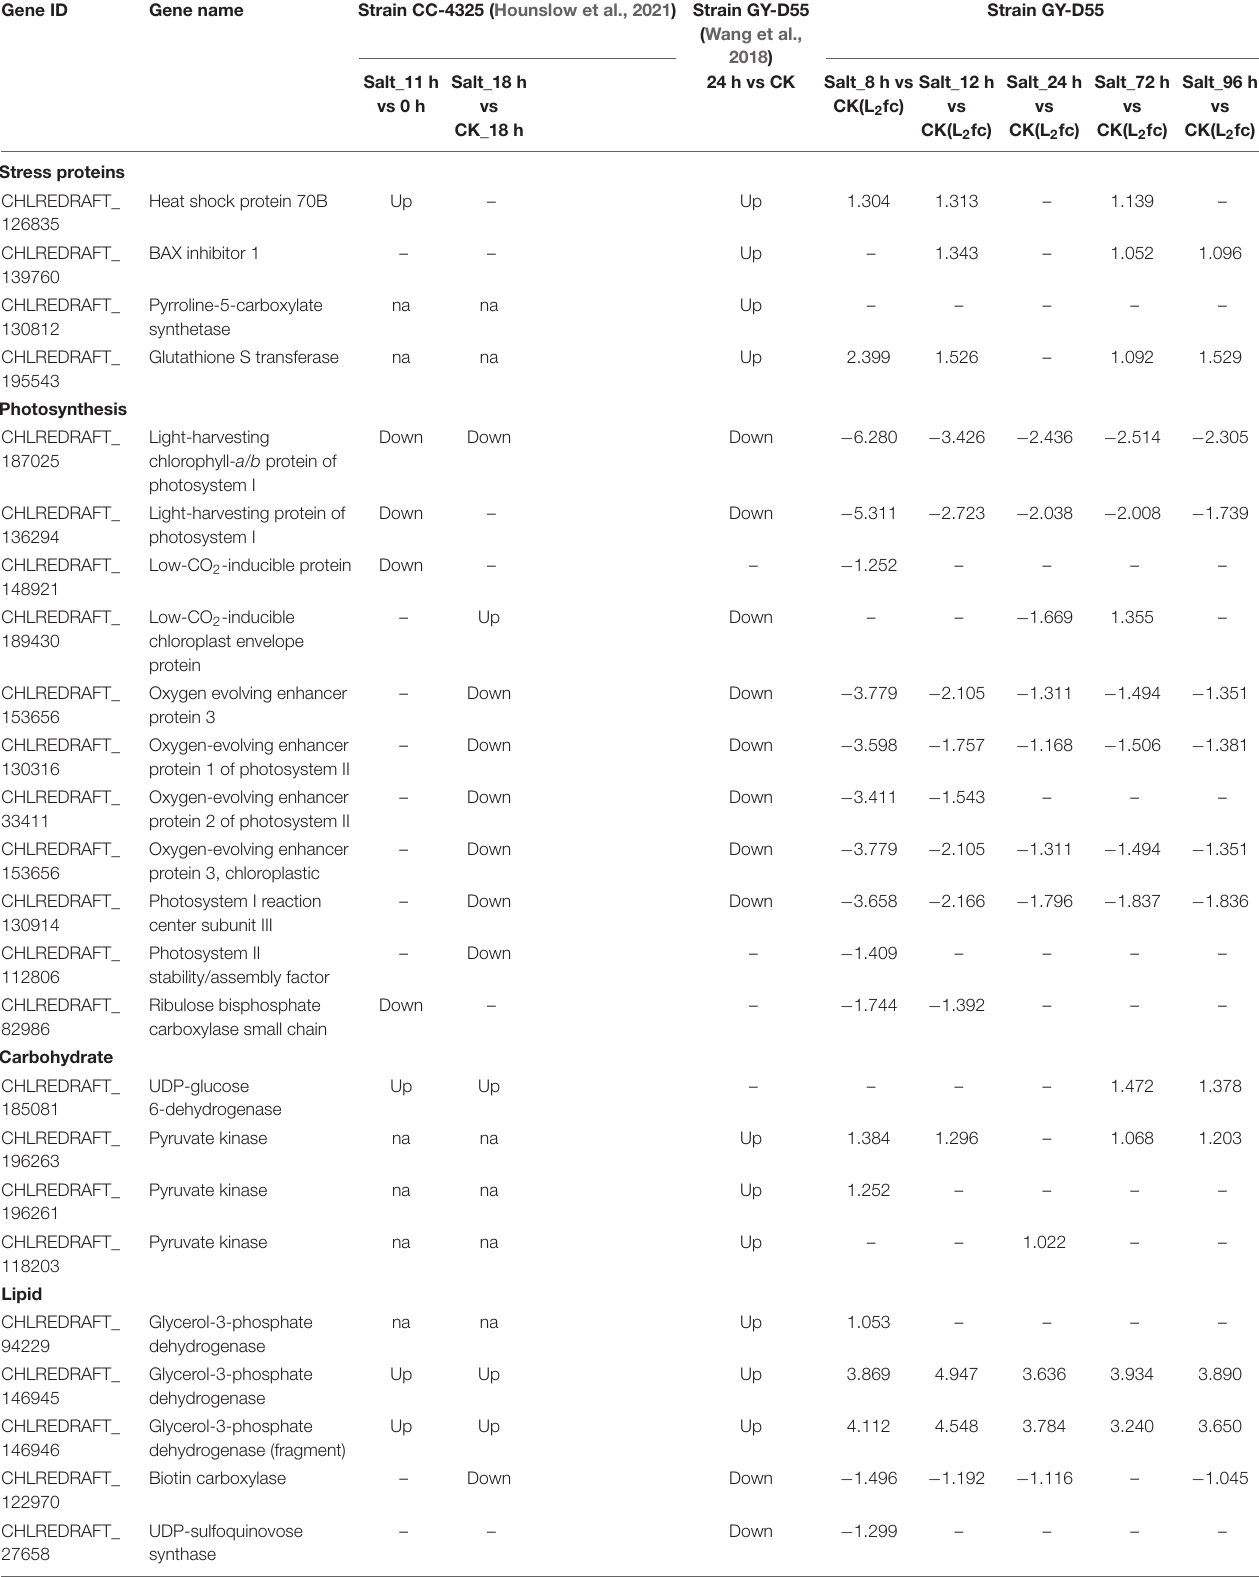
TABLE 2 | Comparisons of gene/protein changes during salt stress in published studies and this study. Gene